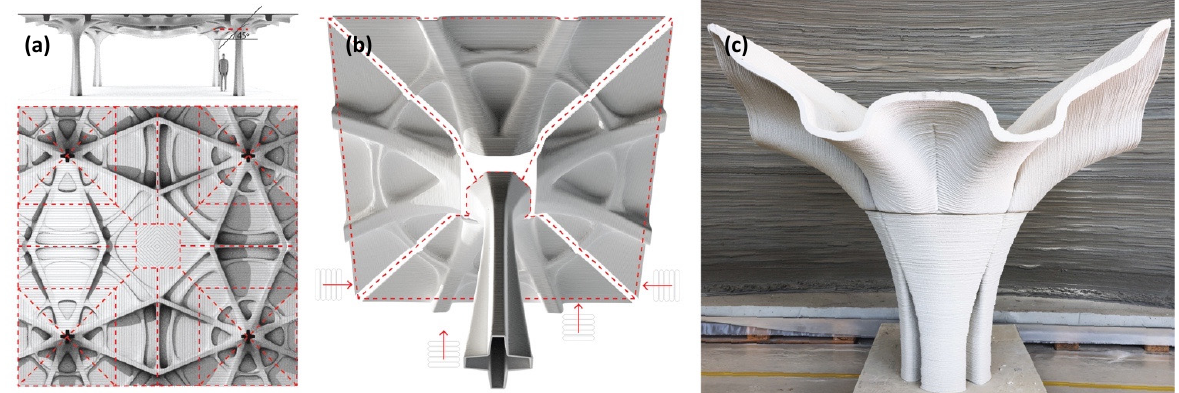
Figure 8. Ribbed slabs with 3D concrete printed formwork: (a) visualisation of the designed ribbed slab; (b) segmentation of the column to slab connection; (c) prototype of the column to slab